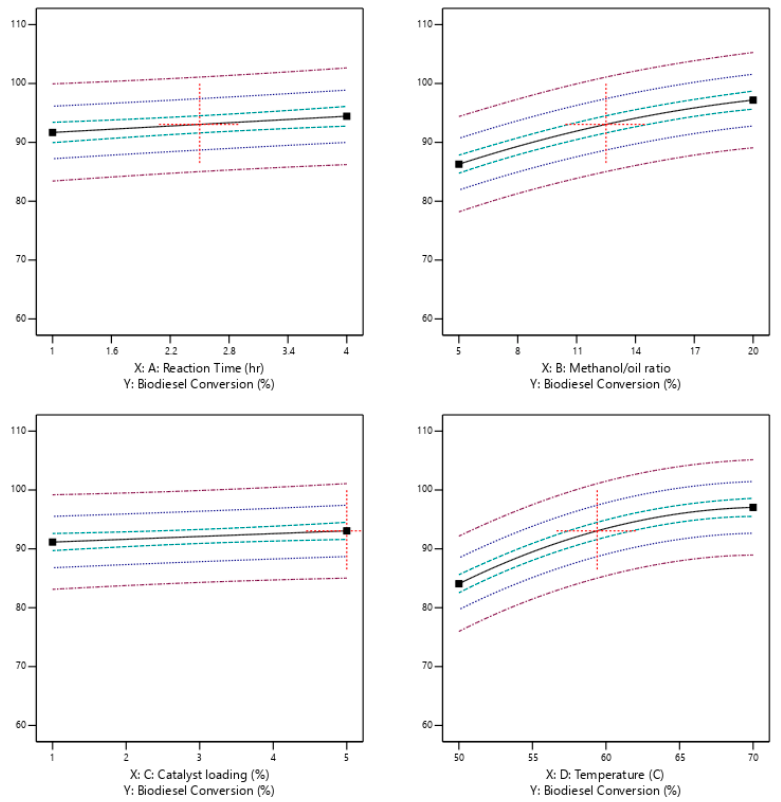
Figure 5. Impact of reaction parameters on the conversion of biodiesel.